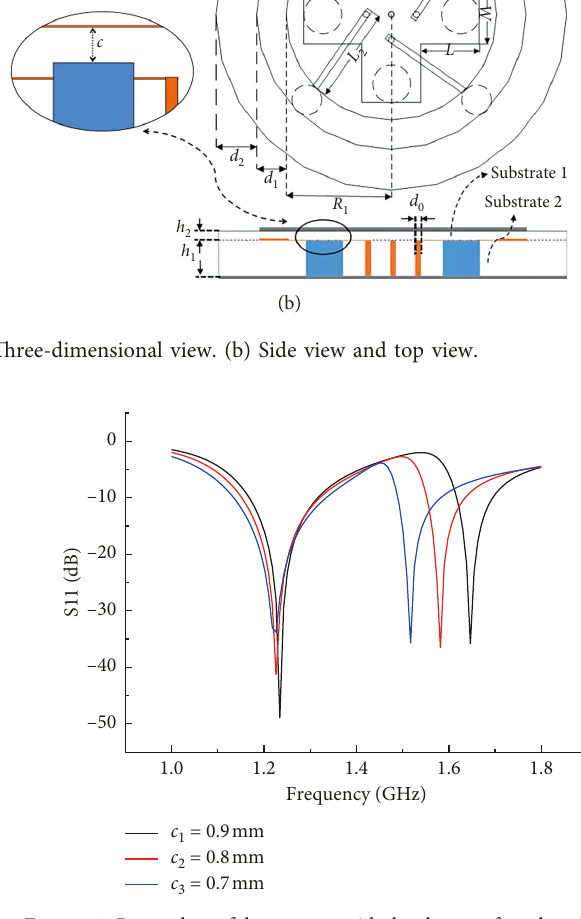
Figure 3: Return loss of the antenna with the change of gap length